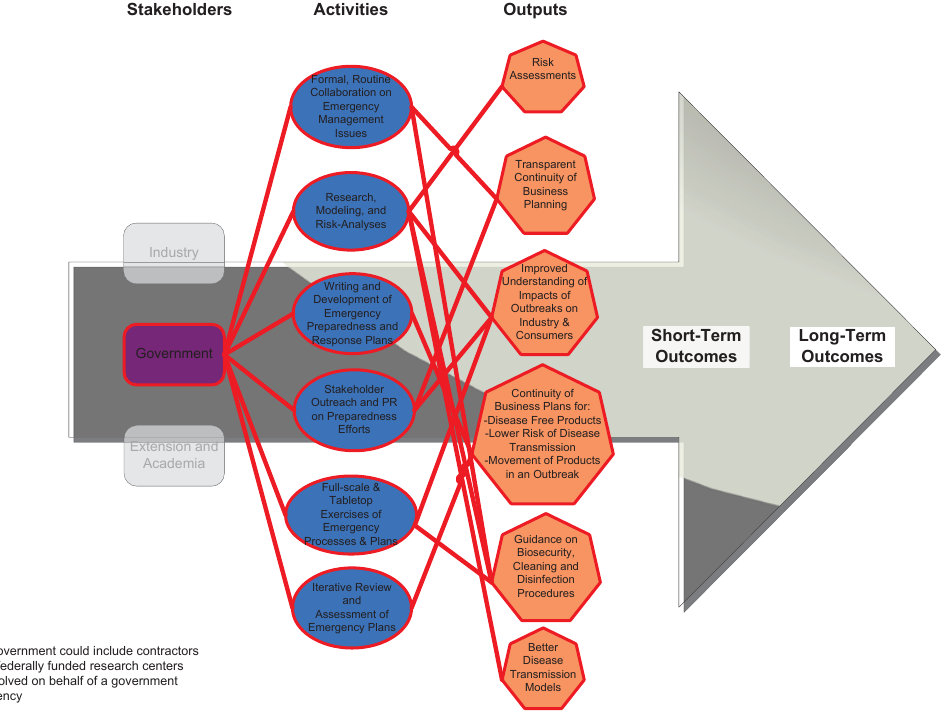
Figure 2. Government’s lead responsibilities in continuity of